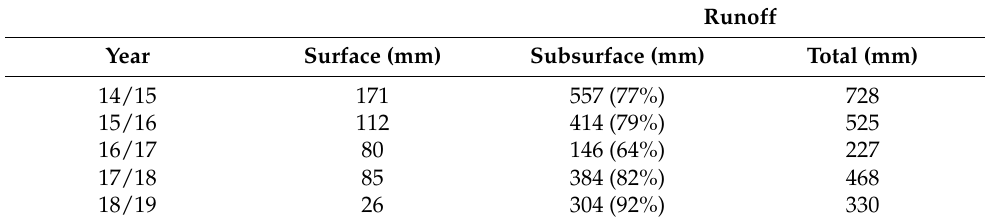
Table 5. Average yearly runoff (mm) for the nine plots and the share of drainage and surface